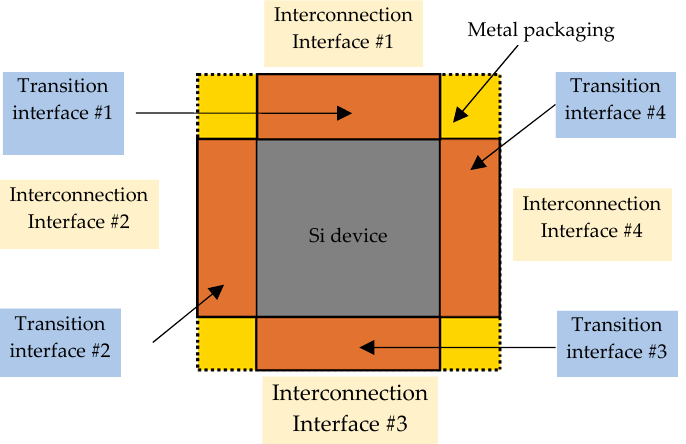
Figure 10. Concept of the proposed module, highlighting the transition and connection interfaces.